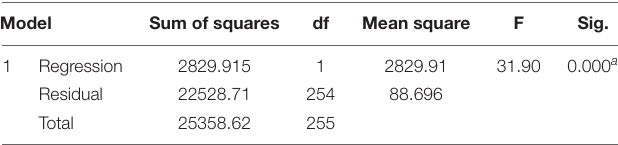
TABLE 5 | ANOVA for regression.